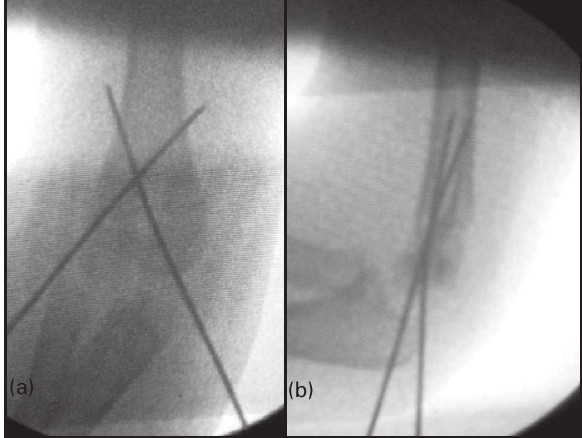
Figure 2. Intra-operative picture of c-arm after fixing with k-wire (a) anterior-posterior (AP) and (b) lateral view